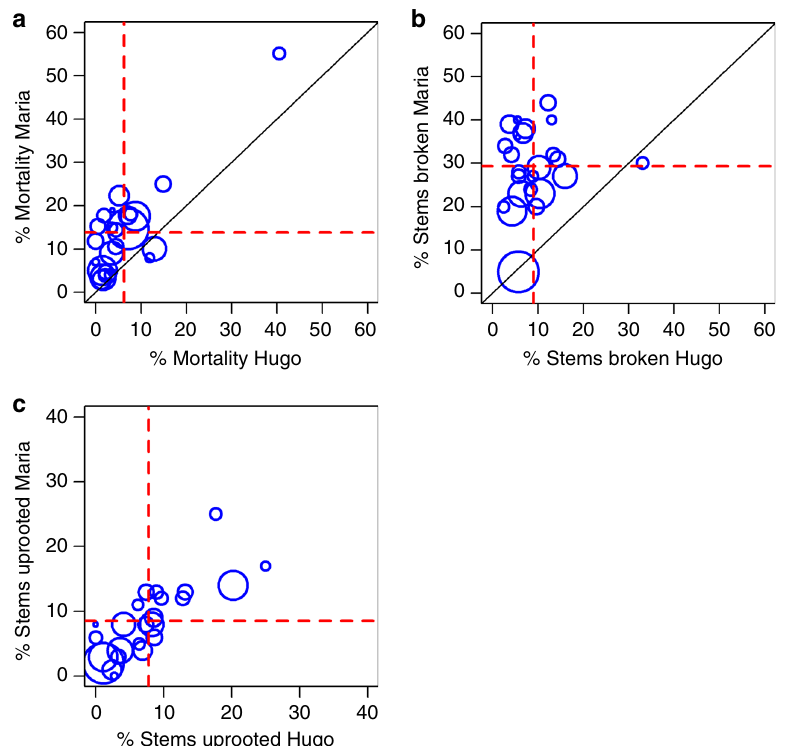
Fig. 2 Rates of immediate mortality ( a ), stem break ( b ), and uprooting ( c ) as a result of Hurricanes Hugo (1989) and María (2017) for 24 tree species. Size of circles is proportional to the number of stems. Dashed red lines indicate community-average